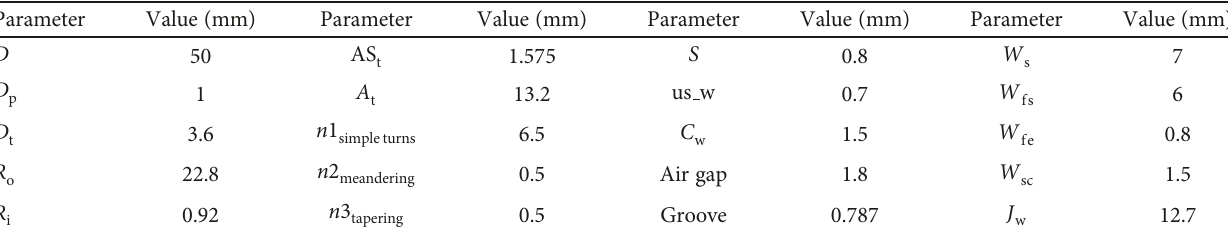
Figure 2: Side view of the proposed spiral antenna. Table 3: Dimensions of spiral